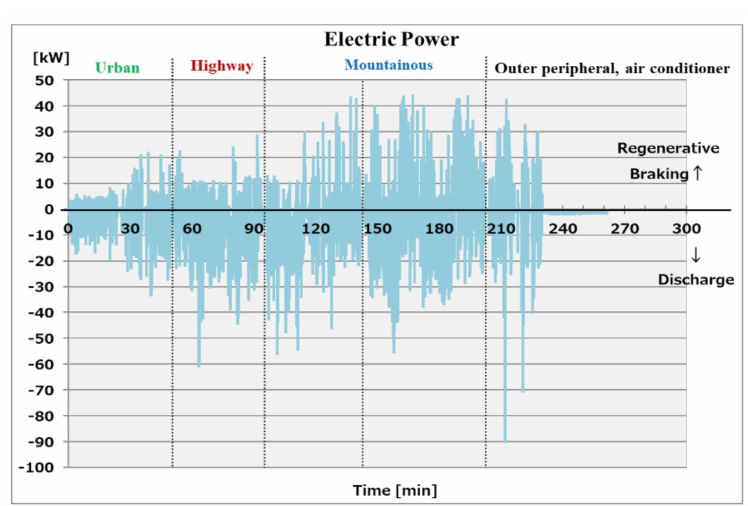
Figure 16. Current waveform of the test.